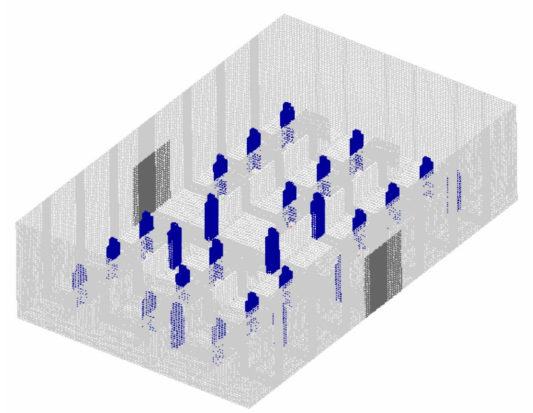
Figure 3. 3D distribution of the